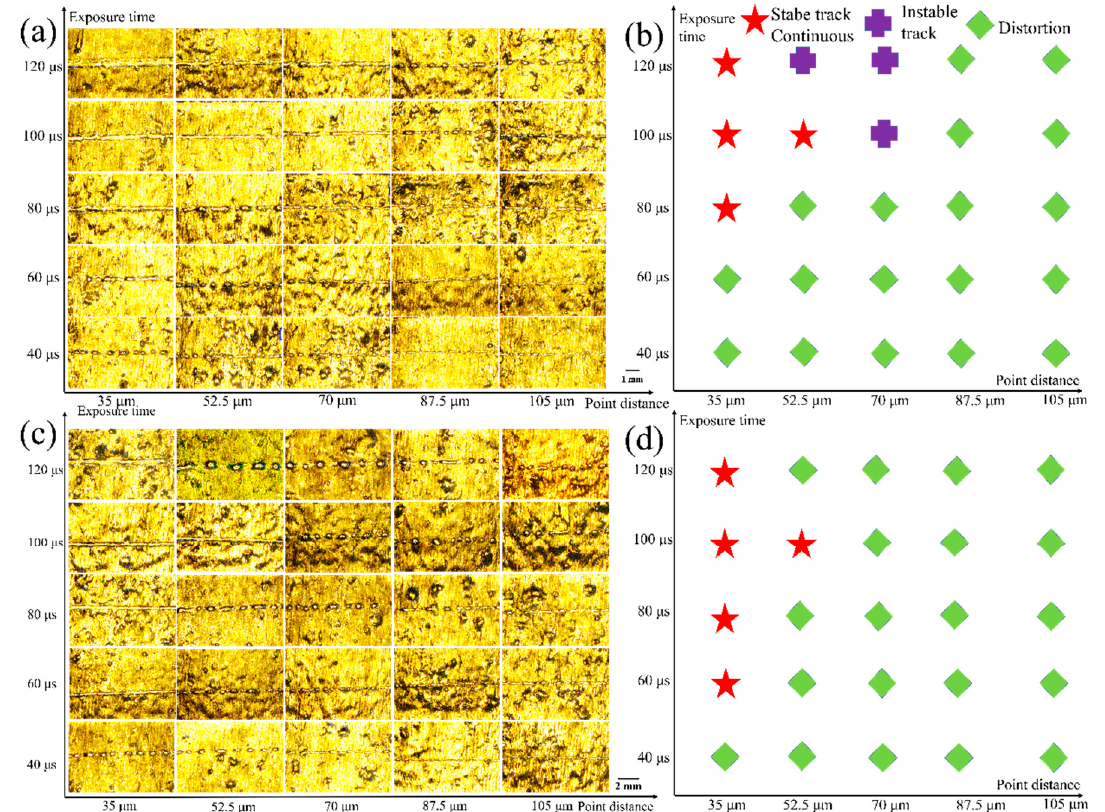
Figure 3. The single-track experiments ( a ) surface morphologies with a power of 350 W and a layer thickness of 50 µ m; ( b ) process results of ( a ); ( c ) surface morphologies with a power of 350 W and a layer thickness of 150 μ m; ( d ) process results of ( c ).